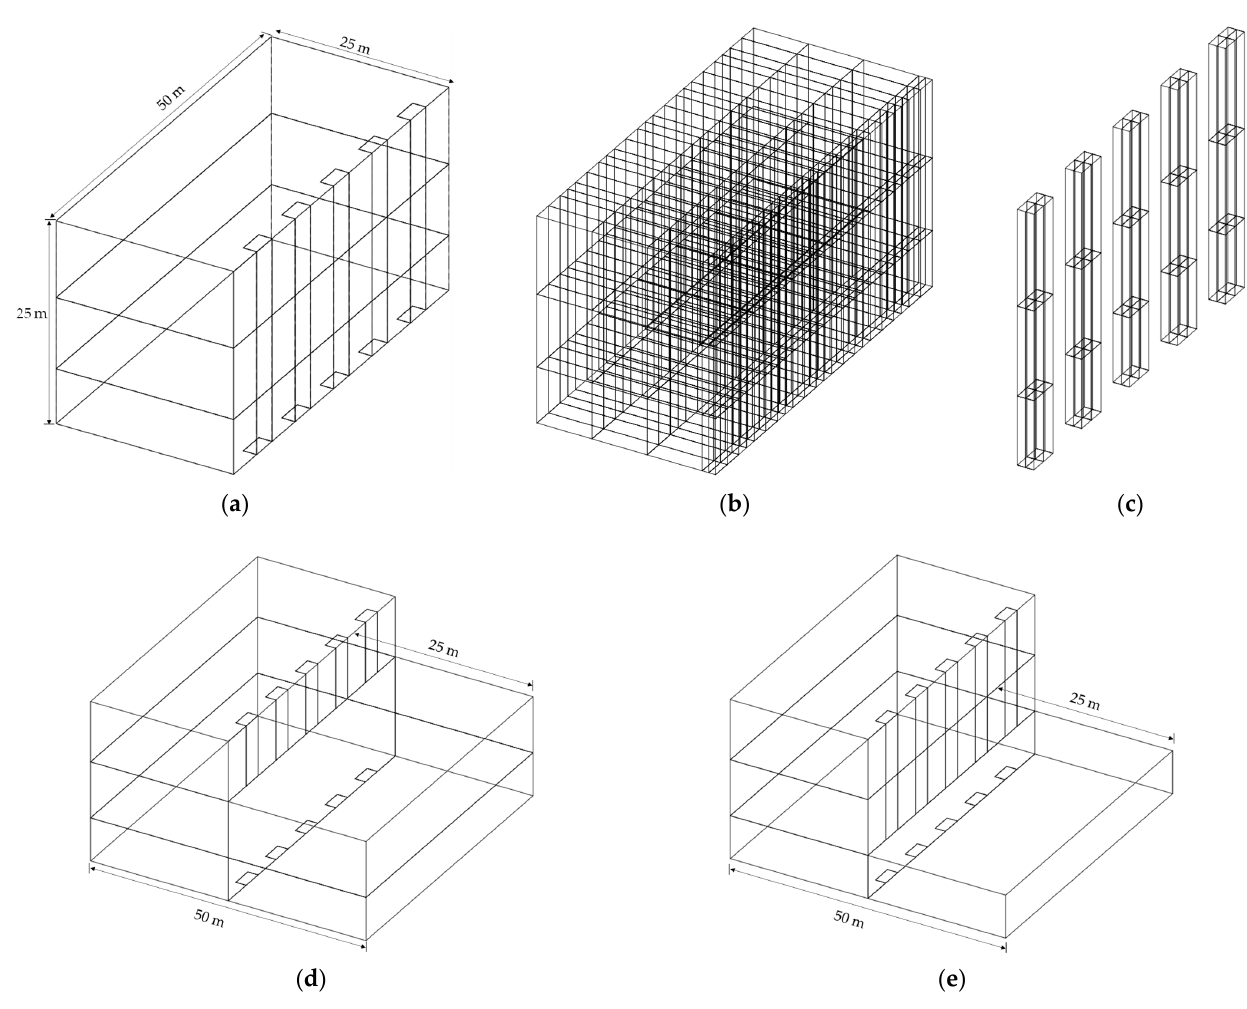
Figure 10. Mesh of the 3D finite element analysis: ( a ) borders and dimensions; ( b ) gravel layer and retaining piles; ( c ) retaining piles; ( d ) first-stage stratum excavation; ( e ) second-stage stratum excavation.